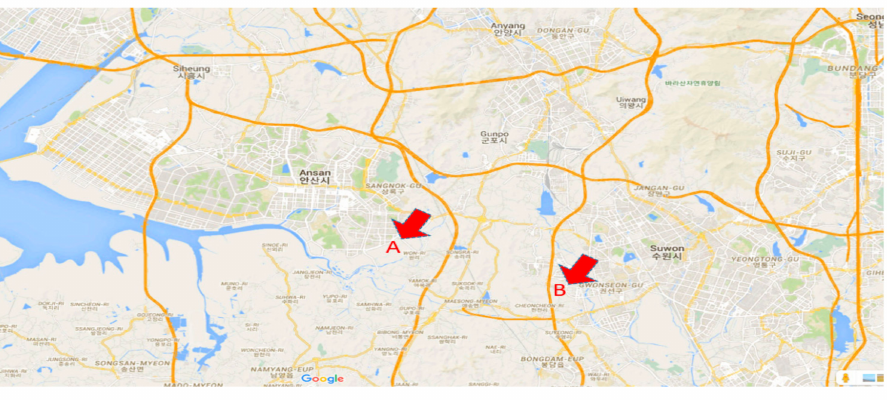
Figure 1. The data collection area (“A”) and weather observation area (“B”) in Gyeonggi-do,